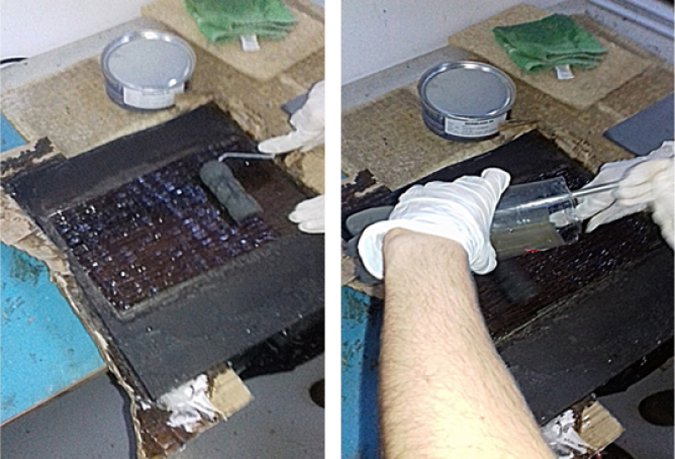
Process lamination.